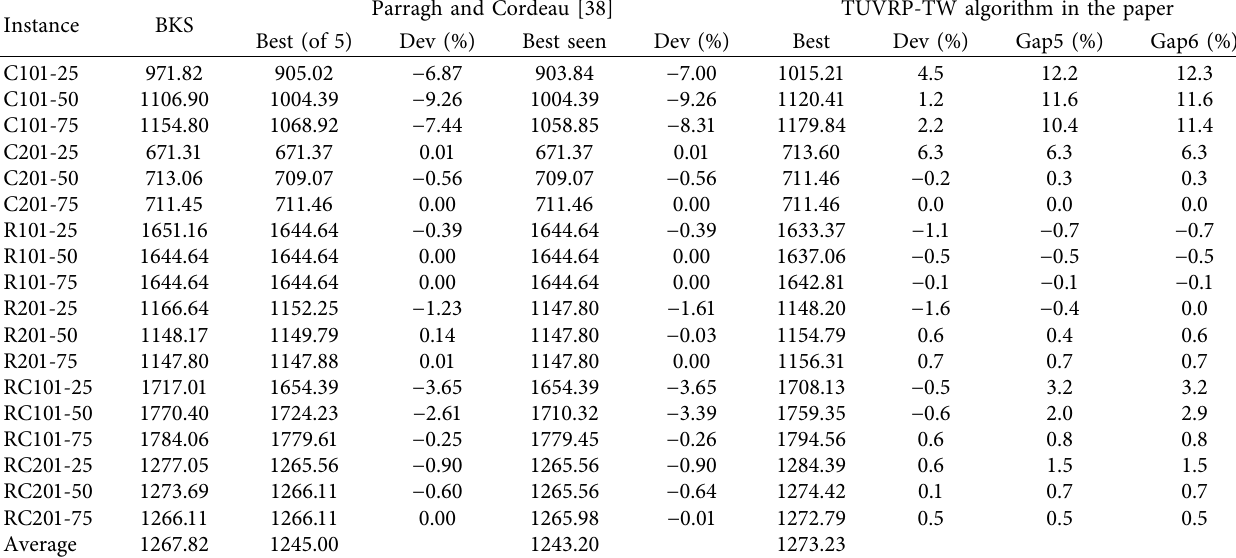
Table 5: The TUVRP-TW heuristic results for TTRPTW benchmark